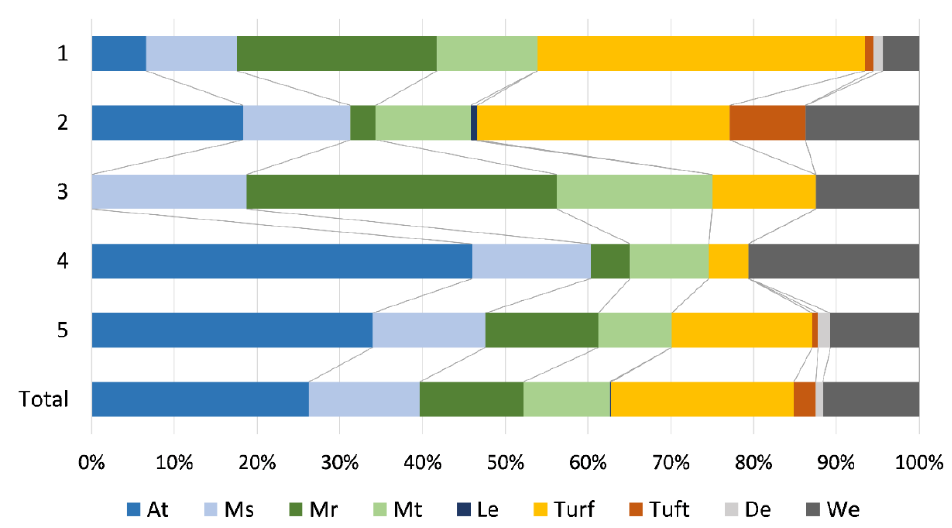
Figure 6. Lifeform spectrum of freshwater bryophytes for TWINSPAN groups and a total sample of 76 bryophyte-dominated sites (At—aquatic trailing, Ms—smooth mat, Mr—rough mat, Mt—thalloid mat, Le—lemnoid, De—dendroid, We—weft).